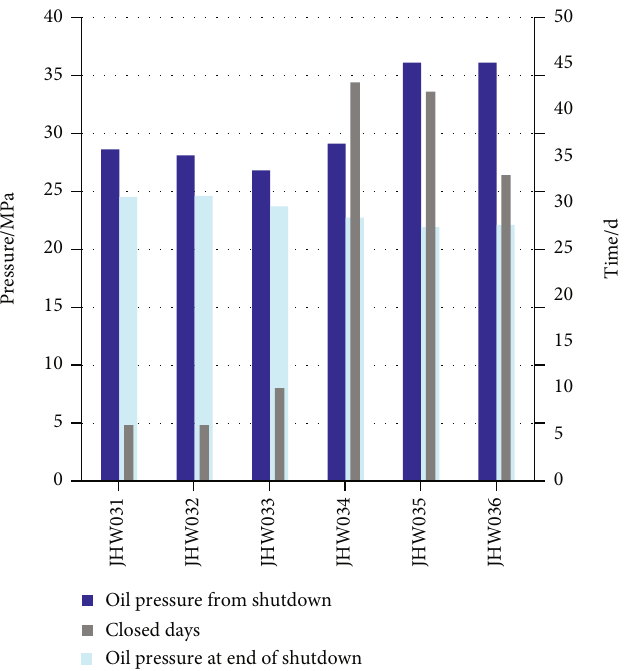
Figure 14: Di ff erent well closures of wells J1 – J6.